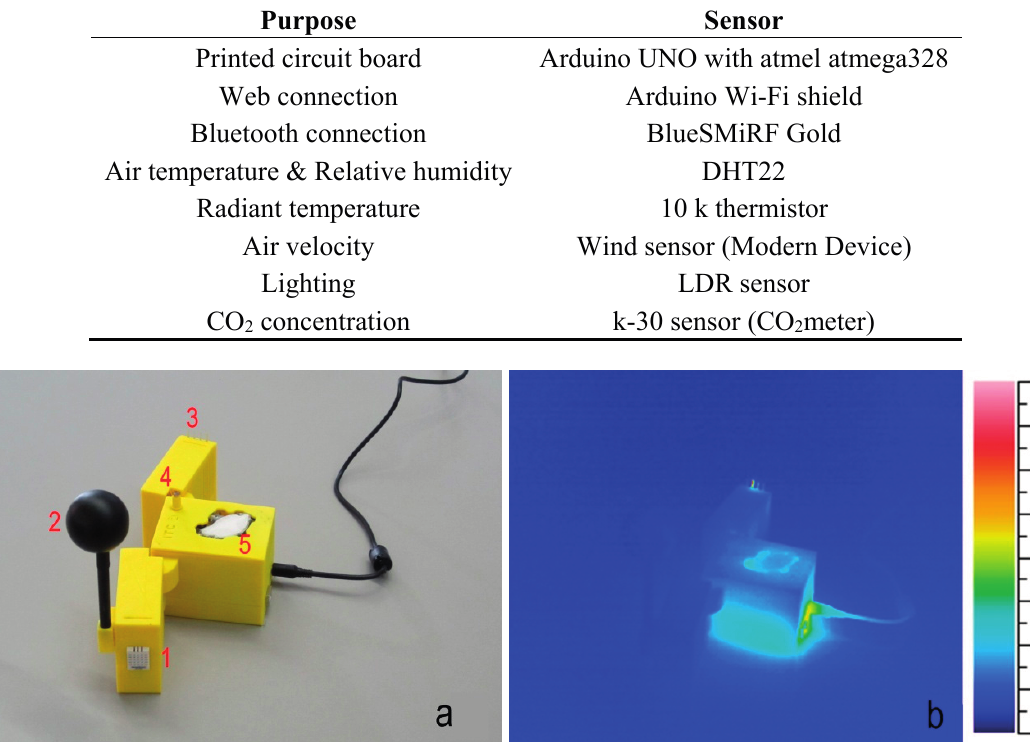
Figure 1. ( a ) Assembled case with electronics; ( b ) Thermographic